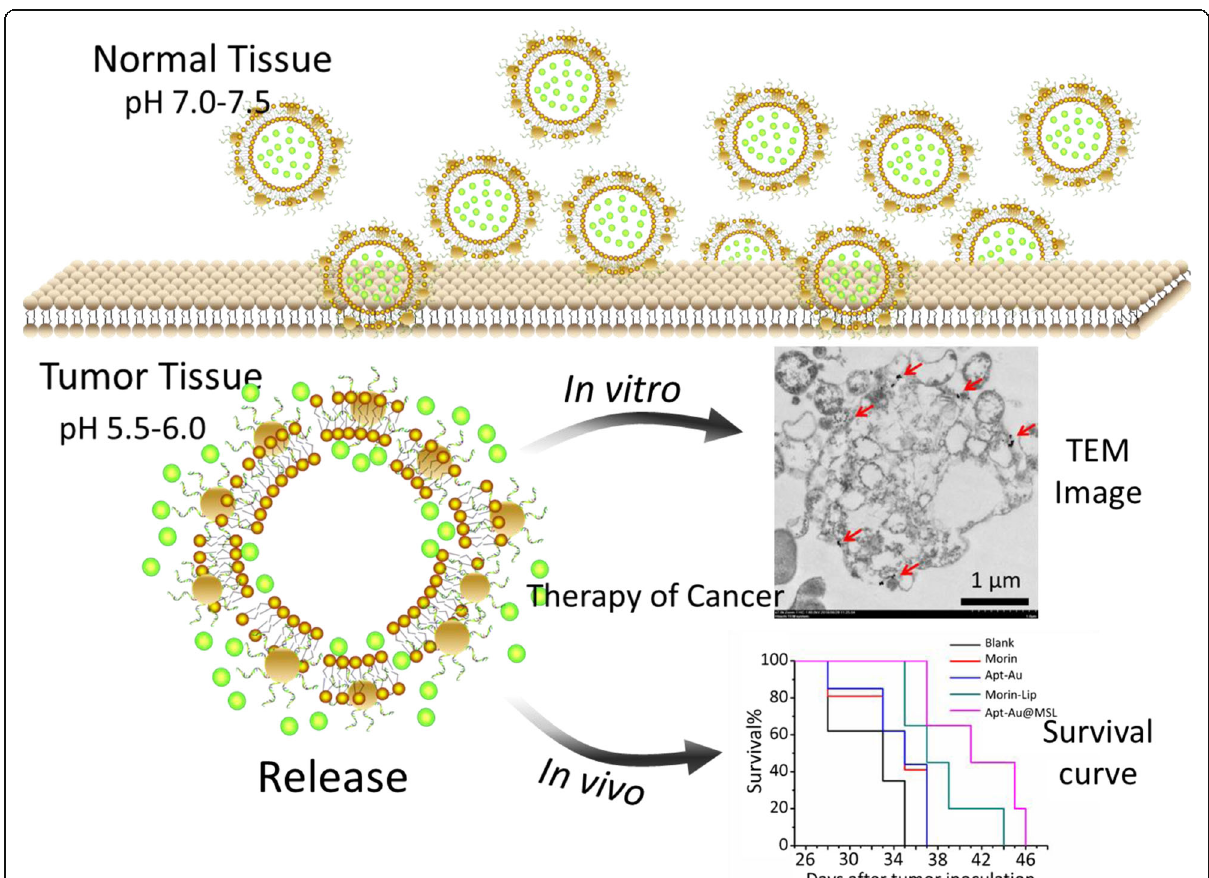
Fig. 2 Proposed schematic diagram of our designed Apt-Au@MSL containing Morin for drug delivery to cancer cells with tumor-targeted